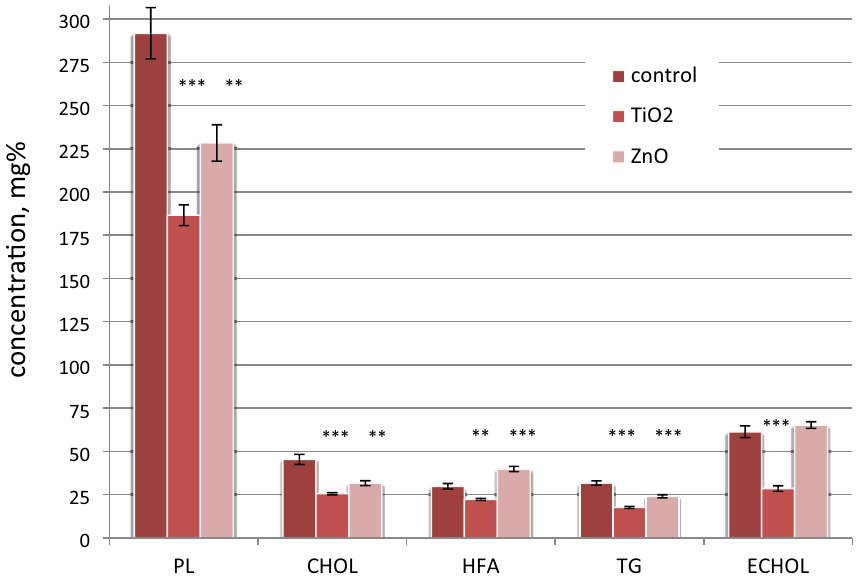
Figure 11. Concentrations of lipids (phospholipids (PL), cholesterol (CHOL), higher fatty acids (HFA), triglycerides (TG) and cholesterol ethers (ECHOL) in the blood plasma of rats in the control group (n = 7) and under the chronic in vivo effect of ZnO and TiO 2 ANs for 6 months (n = 7); * p < 0.05 and ** p < 0.001 compared with control.